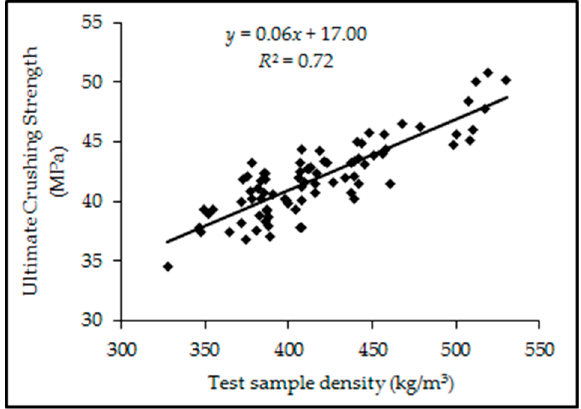
Figure 5. Relationship between test sample density and ultimate crushing strength parallel to the grain.